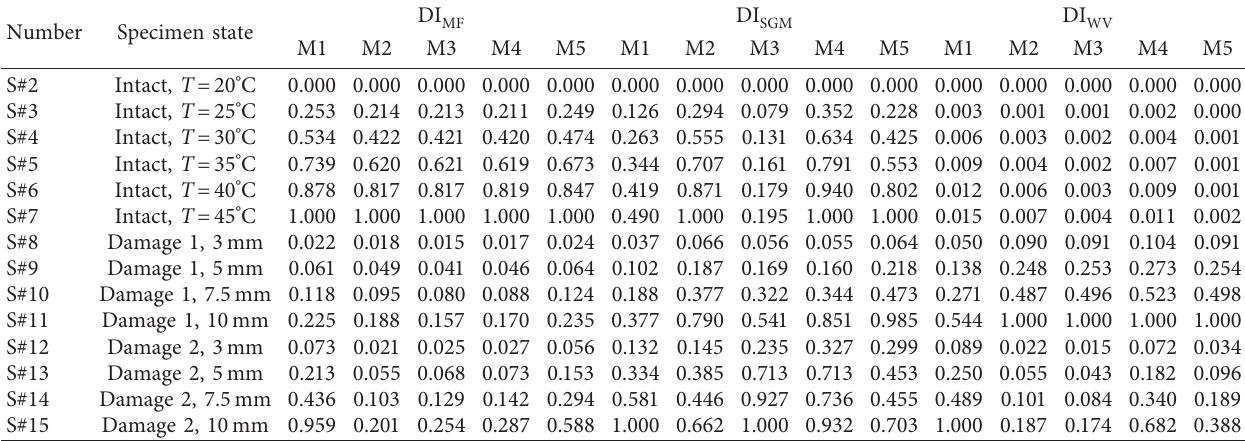
Table 2: Damage detection results of the numerical experiment.